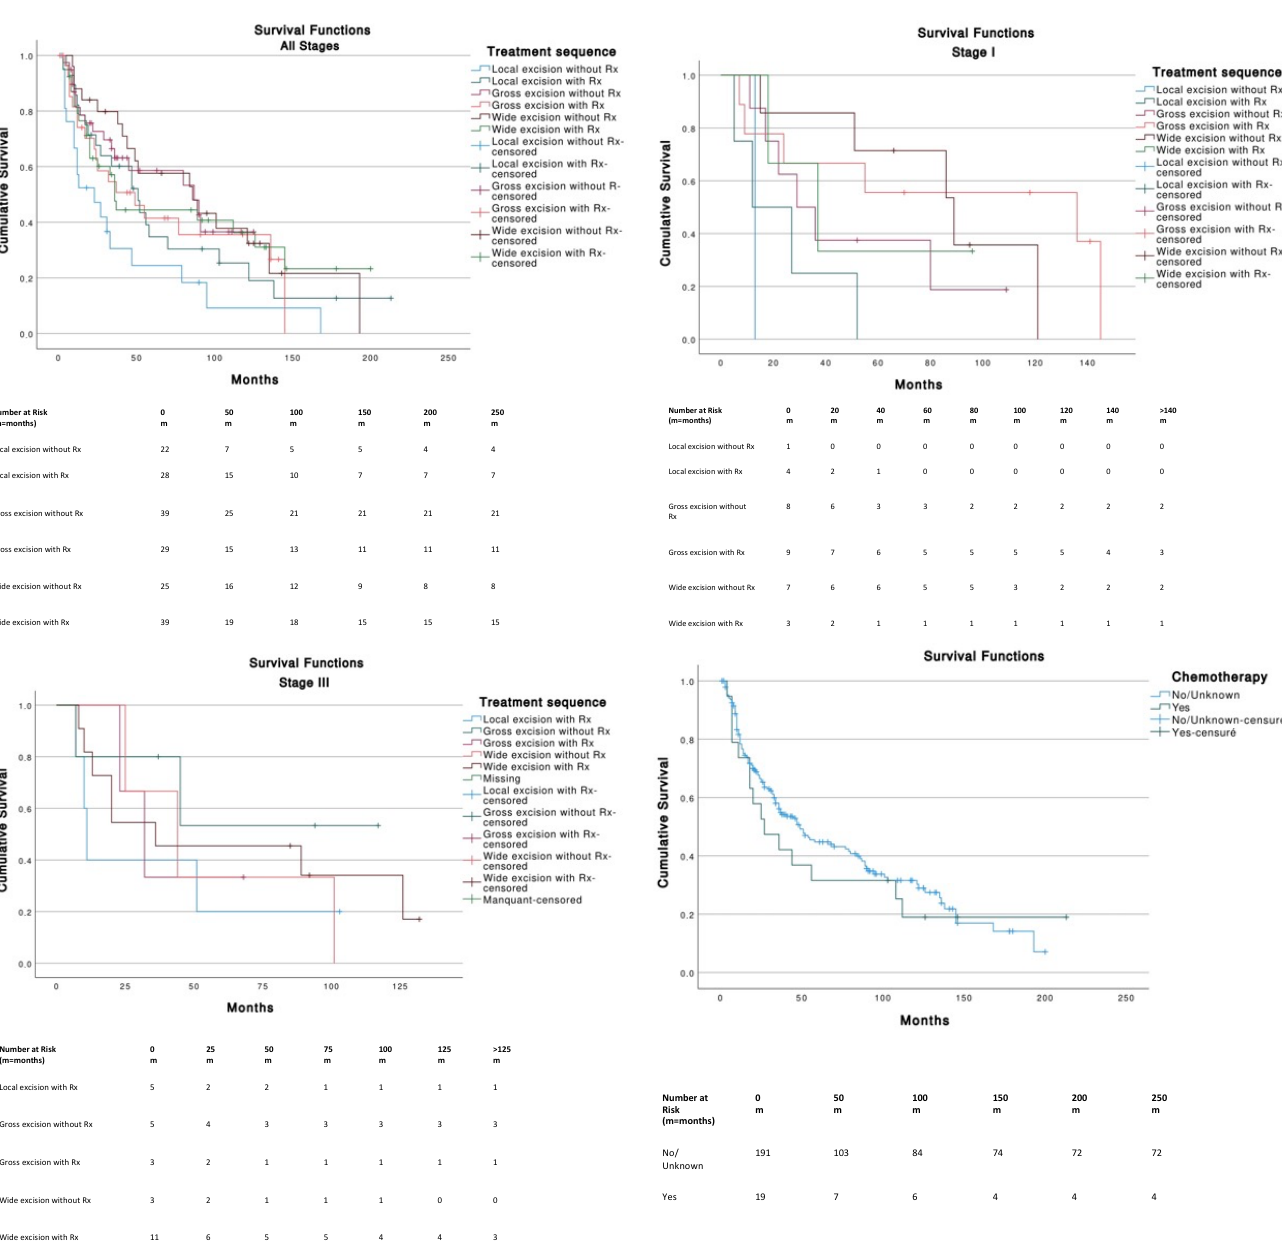
Age at diagnosis, sex, race, TNM, stage and therapeutic strategy were identified